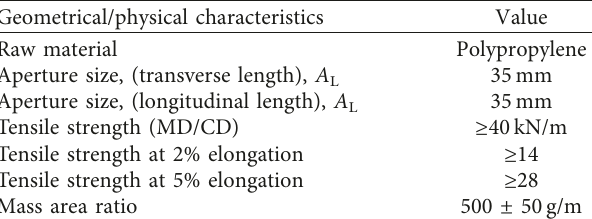
Figure 5: Bidirectional plastic geogrid. Table 2: Physical property of